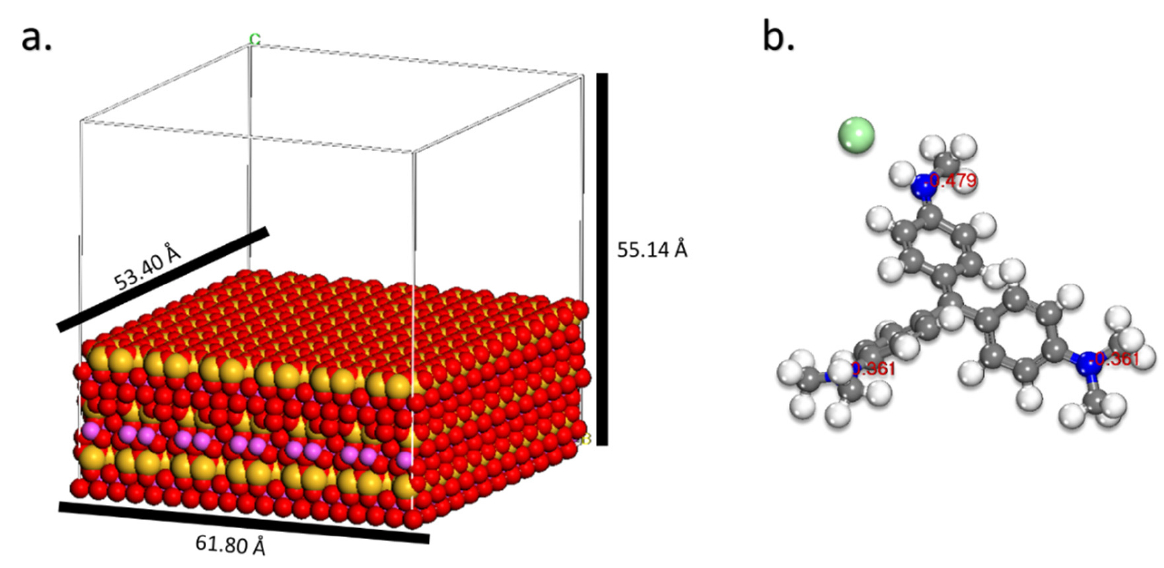
Figure 1. Molecular models used in the theoretical calculations: ( a ) HNC surface, ( b ) MV molecule (with MAC charges).